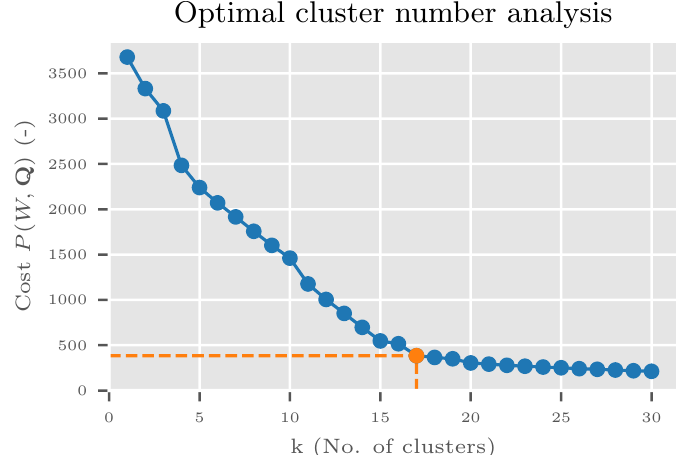
Figure 7. Optimal cluster number analysis for ILSVRC2012 experiment. An analysis was done by the k-Modes algorithm [41–43]. A clear change of slope is visible at 17 clusters (orange markings). Table 3. Transformation of the dataset D (cid:48) labels into the cognitive relevant labels. No. Transformed Category Original